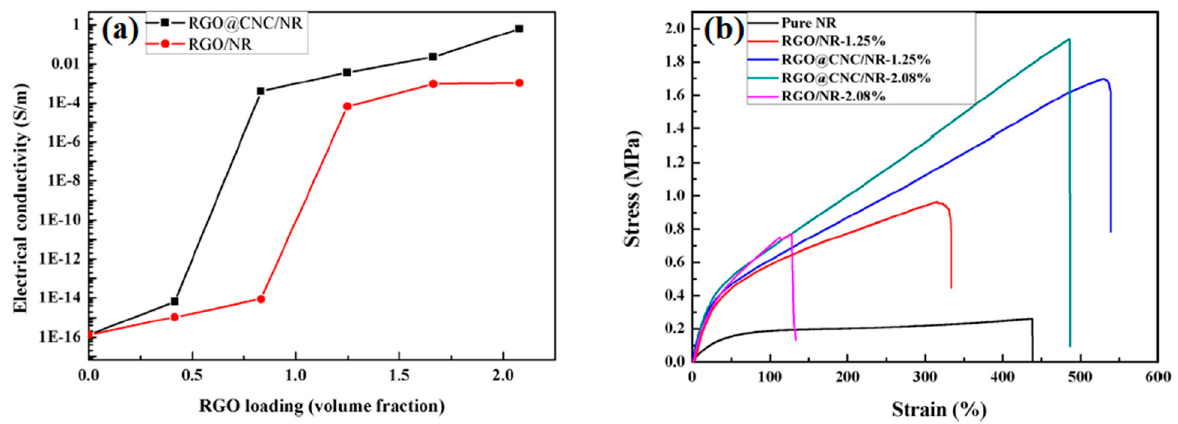
Figure 16. Reduced graphene oxide (RGO)/CNC/NR nanocomposite properties: ( a ) electrical conductivity and ( b ) tensile properties (reproduced with permission from [167]).